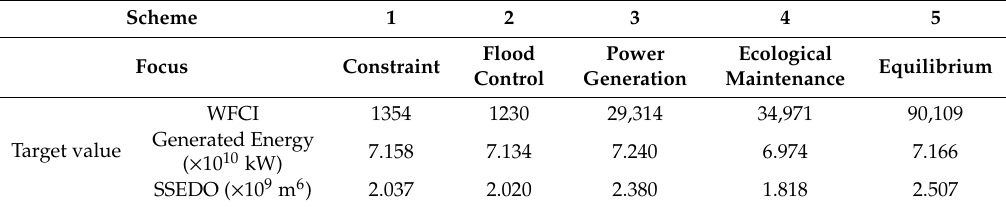
Table 2. The scheduling results of each typical scheme with VA-NSGA-III.